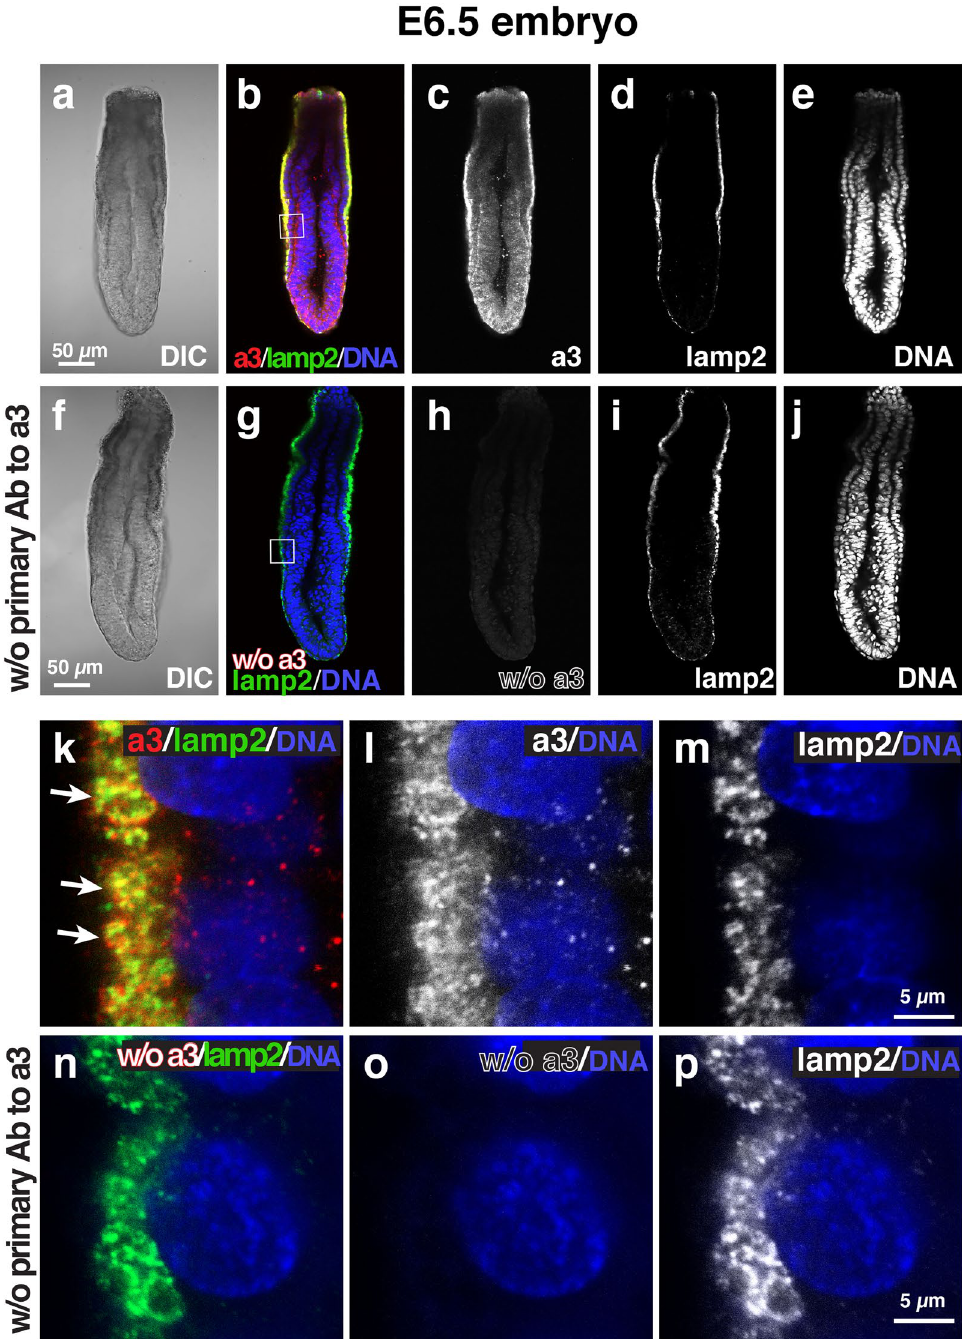
Figure 4. Localization of a3 subunit isoforms in mouse E6.5 embryos. Wild-type E6.5 embryos (n = 10) were isolated and stained with antibodies against a3 (red) and lamp2 (green). Nuclear DNA is also labelled (blue). Arrows indicate the apical vacuole. The control embryos (n = 5) labelled without the primary antibodies against a3 (w/o primary Ab to a3) was shown in ( k – j , n – p ). The secondary antibody alone controls in which the embryos were labelled without primary antibodies against the a3 isoform were performed in parallel and the images were obtained under the same microscopic setup. The boxed region in ( b , g ) is magnified and shown as ( k – m , n – p ), respectively. Scale bars represent 50 µm and 5 µm in ( a – j,k – p ),